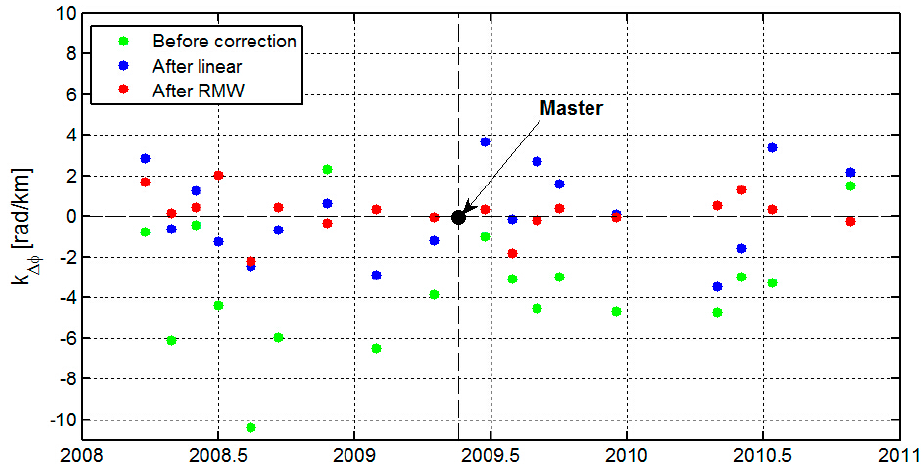
Figure 5. Comparing the local correlation k ∆ φ between the interferogram ∆ φ and topography h . Only pixels with altitude above 800 m are used. Where ∆ φ “ k ∆ φ h ` φ c , then k ∆ φ is estimated before (green points) and after correction for the tropospheric delays, using the conventional linear method (blue points) and the RMW method (red points). The constant φ c represents an overall offset and was applied to the whole interferogram.